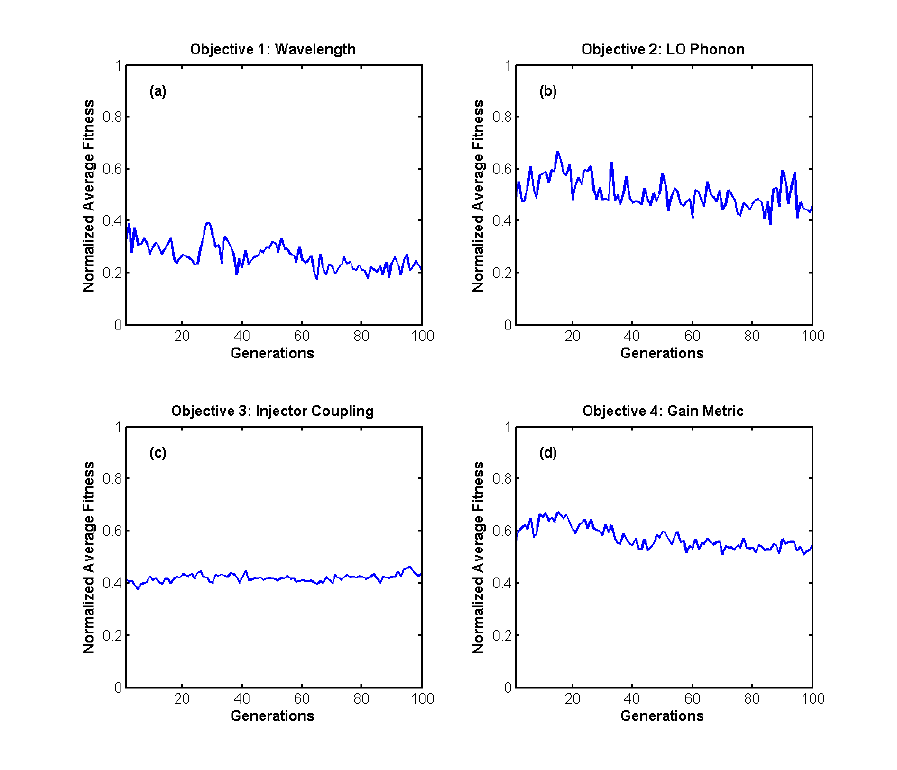
Figure 5. Plots of normalized average fitness per generation for ( a ) wavelength, ( b ) LO phonon, ( c ) injector coupling, and ( d ) gain objectives when initial population was generated from a training